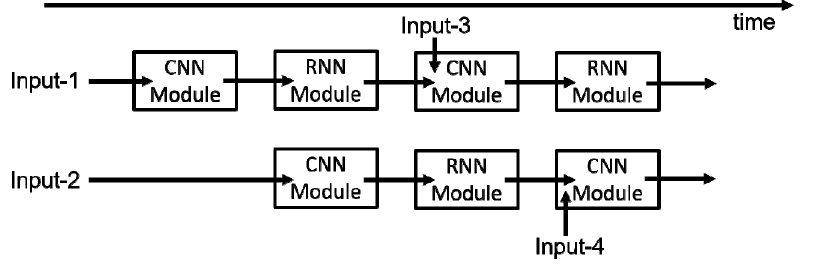
Figure 9. The computing architecture of the neural network in edge components. RNN, recurrent neural network.